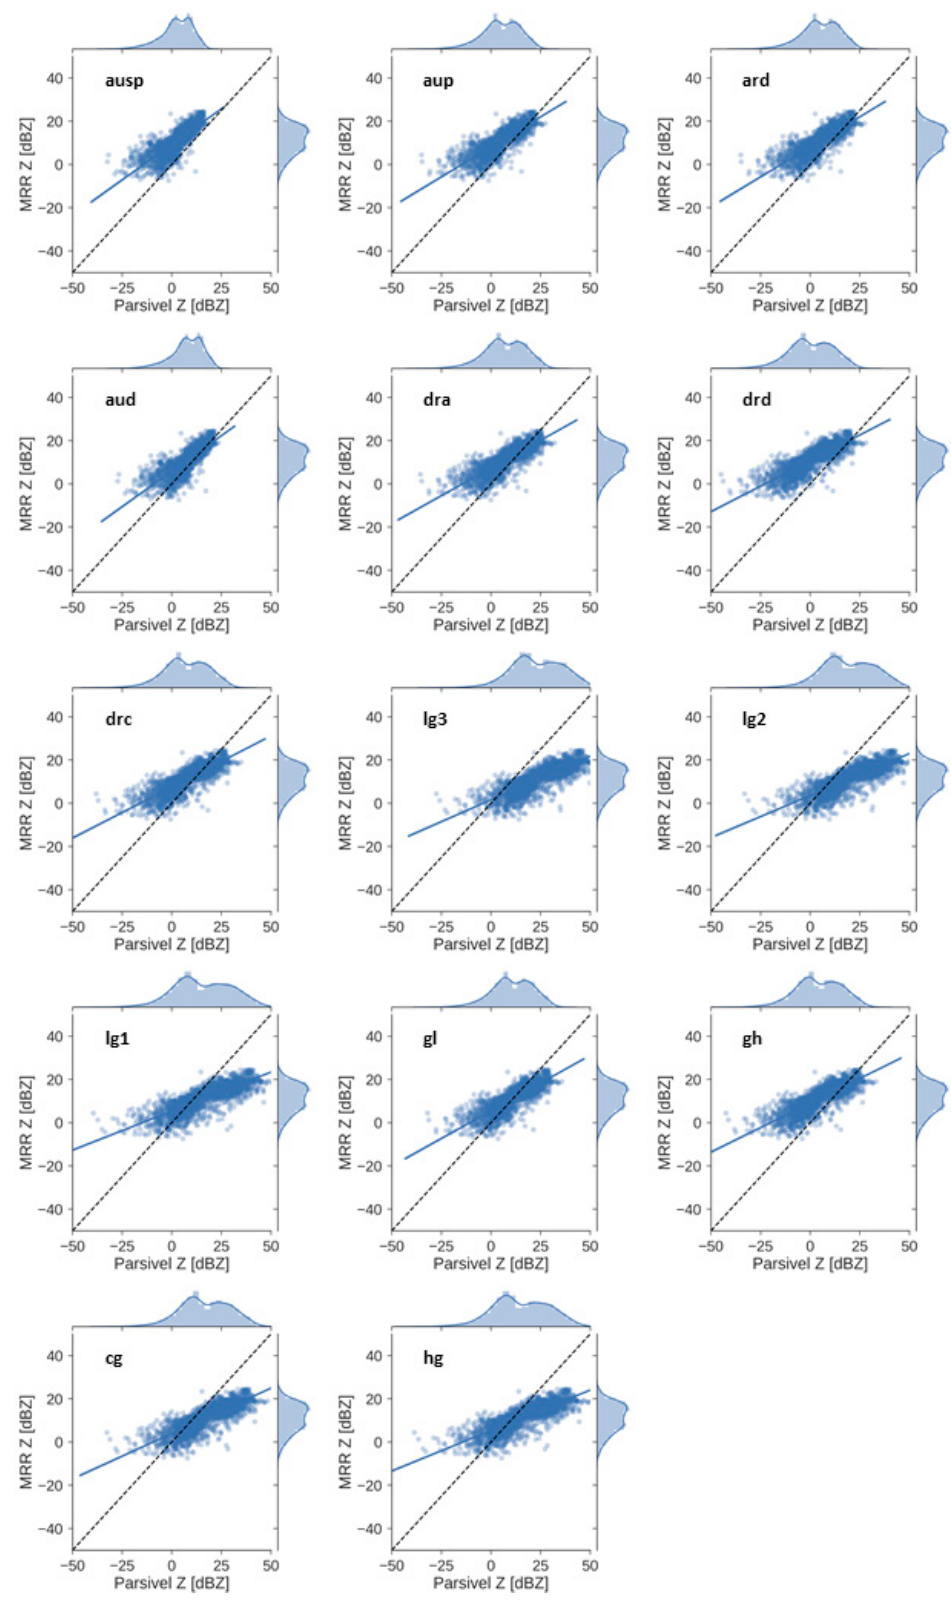
Figure A1. Linear regressions between reflectivity observed by MRR and calculated by Parsivel using 14 different mass-size empirical relations of crystals. Dashed black line indicates the 1:1 relation.